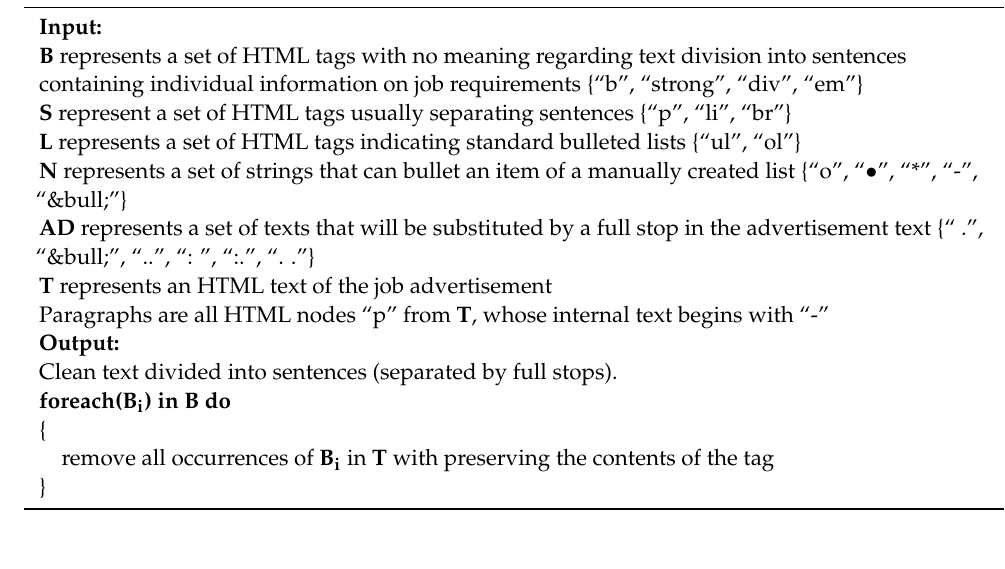
Figure 6. Example of job advertisement data in the JSON format on a job portal www.dice.com (20 March 2021). (accessed on 31 August 2021). Algorithm 1. Processing an HTML page containing job advertisement